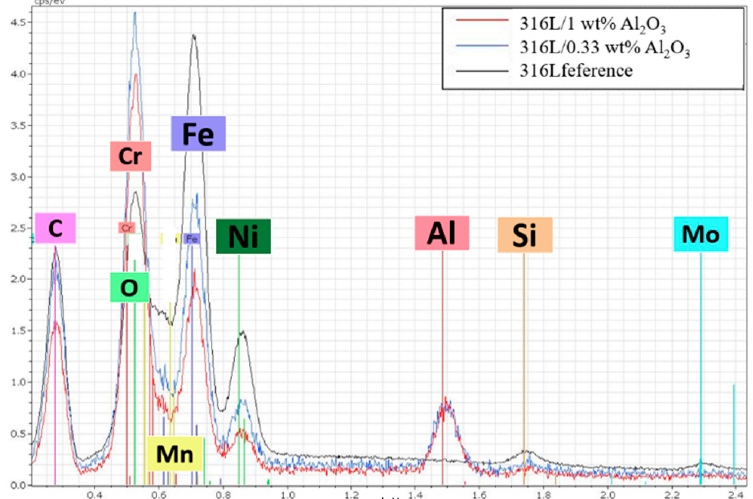
Figure 5. Comparison of the EDS spectra of the sintered composites. The presence of the oxidized 316L debris (Figures 3a and 4a) on the grains’ surfaces was in favour of the formation of Cr 2 O 3 scales/layers, as it provides a higher amount of oxygen along the grain boundaries. The formation of the Cr 2 O 3 scales/layer is highly possible, as this was indicated in other research [27,28]. However, as the EDS peaks of chromium and oxygen overlapped, further investigations are needed in order to confirm it. γ -Fe θ = 43.532 ◦ , 50.705 ◦ and 74.535 ◦ , 3 Ni 2 phase (JPC2:03-065-5131) with the main lines 2 corresponding to the diffracted planes (111), (200) and (220), respectively. The BCC Fe alpha phase (JPC2:03-065-4899) with the main lines of 2 θ = 44.663 ◦ and 82.314 ◦ corresponding to the diffracted planes (110) and (211), respectively, formed after milling. The starting powders had the main lines of 2 θ = 43.576 ◦ , 50.759 ◦ and 74.594 ◦ ,with an average deviation of 0.052 ◦ to the right from the JPC2:03-065-5131 lines. The 316L/0.33 wt% Al 2 O 3 milled powders had the main lines of 2 θ = 43.576 ◦ , 50.605 ◦ and 74.575 ◦ , with an average deviation of 0.005 ◦ from the corresponding JPC2:03-065-5131 lines. The first and third peaks shifted to the right, and the second peak shifted to the left. Two main peaks of an alpha phase corresponding to the Fe alpha JPC2:03-065-4899 were detected as follows: 2 θ = 44.522 ◦ and 82.106 ◦ . The 316L/1 wt% Al 2 O 3 milled powders had the main lines of 2 θ = 43.552 ◦ , 50.746 ◦ and 74.653 ◦ , with an average deviation of 0.060 ◦ to the right of the corresponding JPC2:03-065-5131 lines. Two main peaks of an alpha phase corresponding to the Fe alpha JPC2:03-065-4899 were detected as follows: 2 θ = 44.659 ◦ and 82.215 ◦